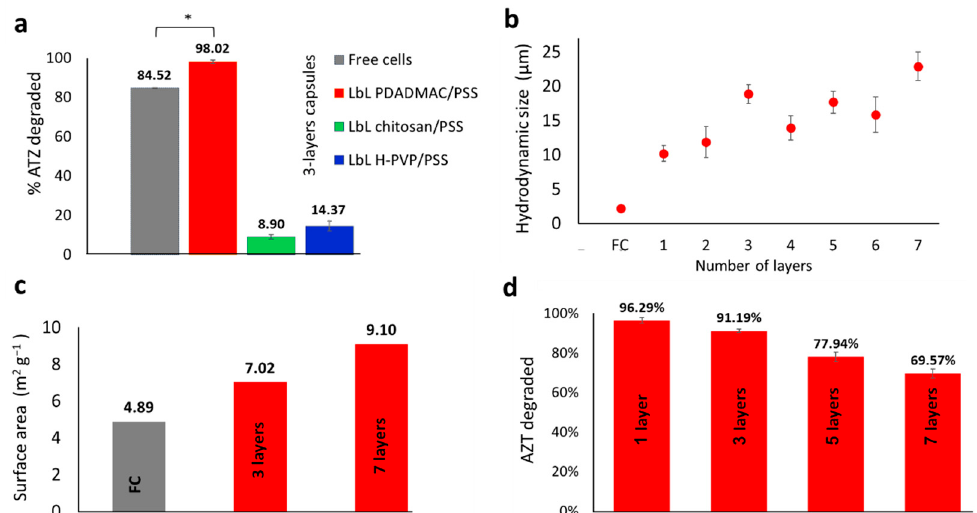
Figure 3. ( a ) ATZ degradation by FC and 3 different LbL biohybrid capsules at initial ATZ oncentration of 15 µ M ( b ) Hydrodynamic size of FCs and LbL polyDADMAC/PSS biohybrid capsules ( c ) Specific surface area of FC and LbL polyDADMAC/PSS biohybrid capsules ( d ) ATZ degradation by LbL polyDADMAC/PSS biohybrid capsules as a function of number of layers. * Indicates significant difference between the groups ( p < 0.05).